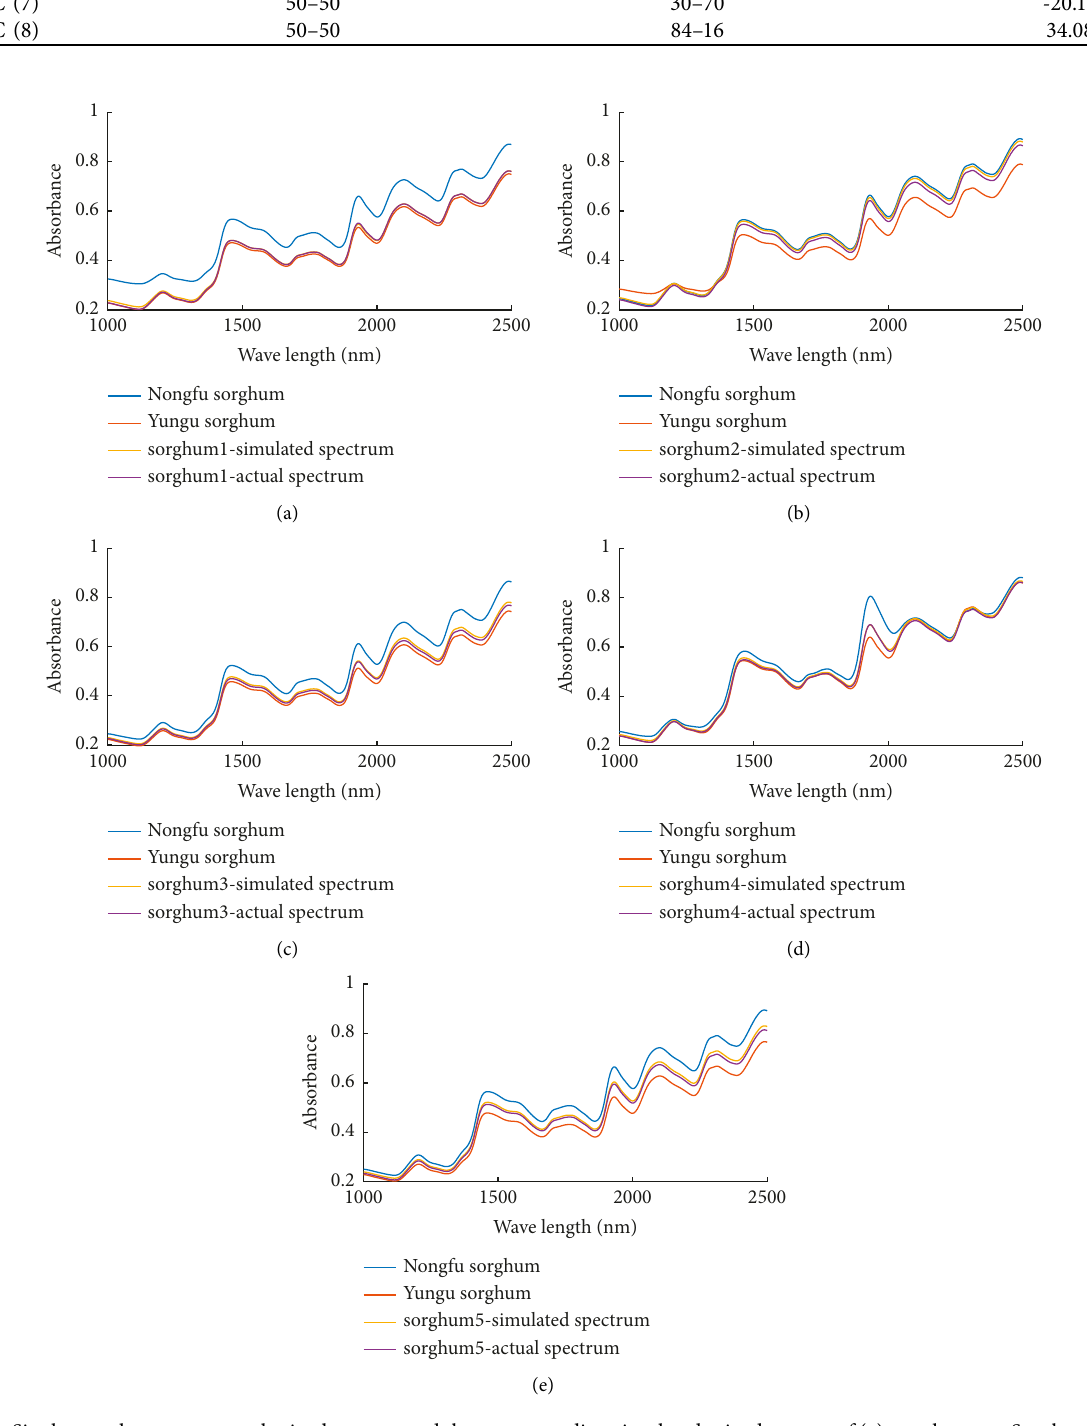
Figure 4: Single sample spectra, actual mixed spectra, and the corresponding simulated mixed spectra of (a)sample group Sorghum1 (10%– 90%), (b) sample group Sorghum2 (90%–10%), (c) sample group Sorghum3 (30%–70%), (d) sample group Sorghum4 (70%–30%), and (e) sample group Sorghum5